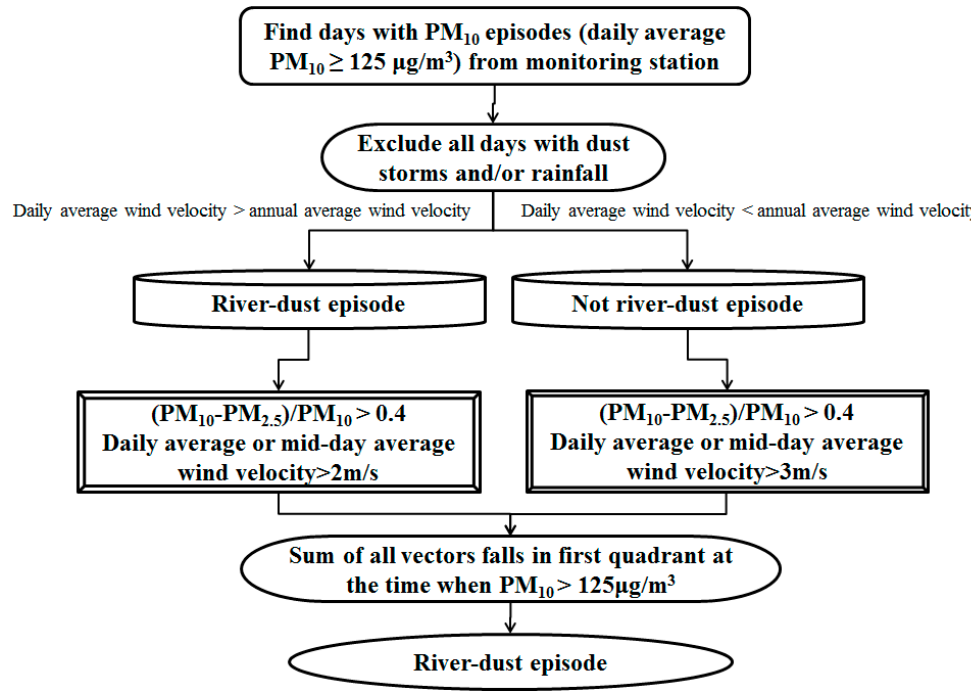
Figure 4. Process to screen for days with river dust episodes.